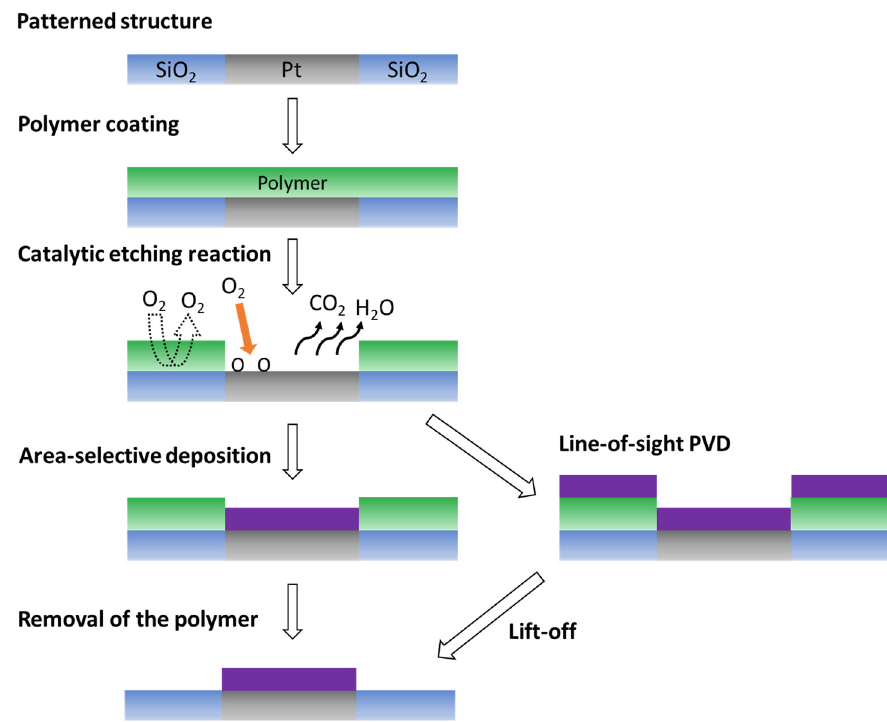
Figure 1. Schematics showing self-aligned polymer etching and the subsequent film patterning through area-selective deposition and lift-off processes. through area-selective deposition and lift-off